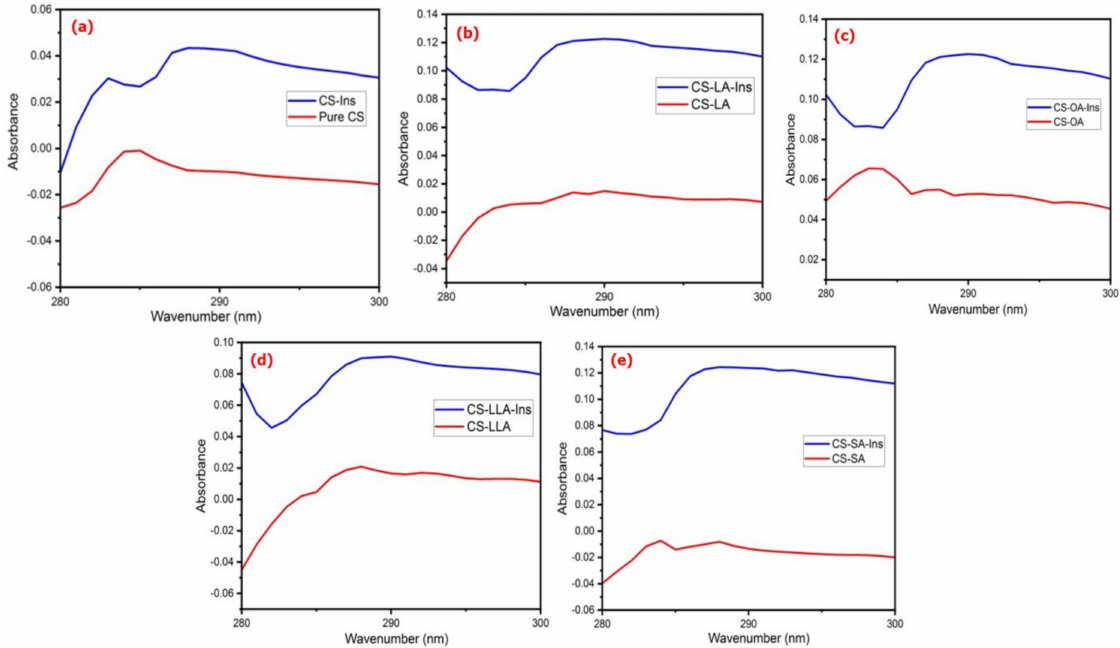
Figure 2. Comparison of UV–Vis spectra for the insulin-loaded CS and grafted CS amides; ( a ) CS-Ins, ( b ) CS-g-LA-Ins, ( c ) CS-g-OA-Ins, ( d ) CS-g-LLA-Ins, and ( e )